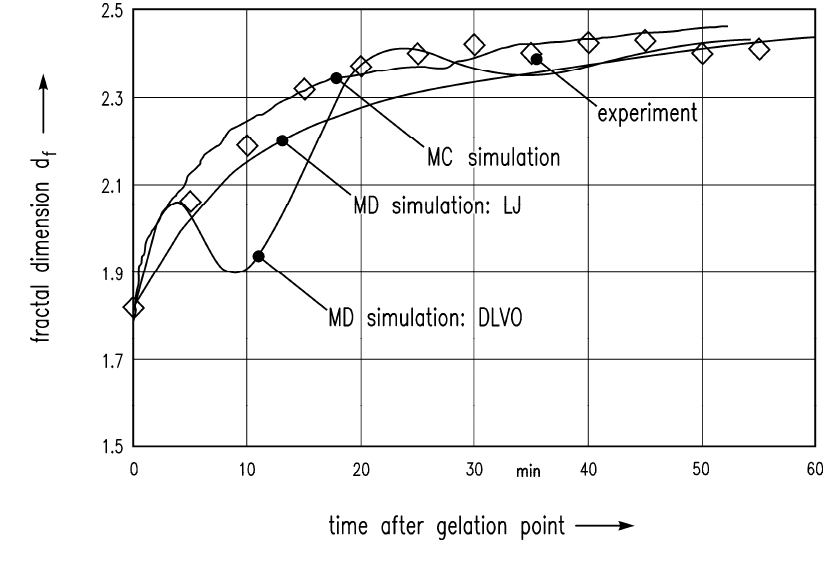
Figure 6. Experimental data of the fractal dimension vs. time after gelation point [22] (rhombi) along with the fractal dimension computed in the MC [40] resp. MD simulations